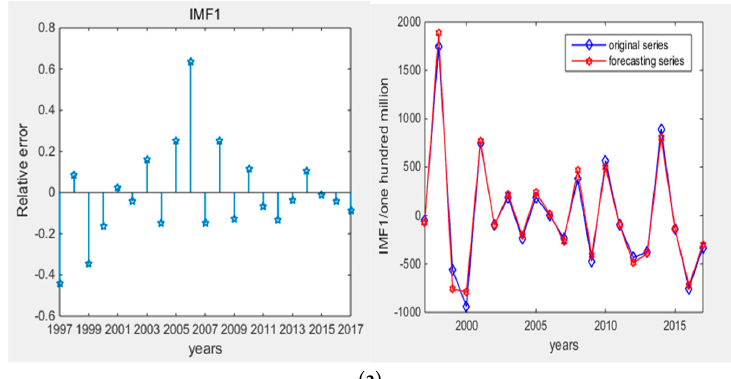
Table 3. Main parameters of the BFO-IELM